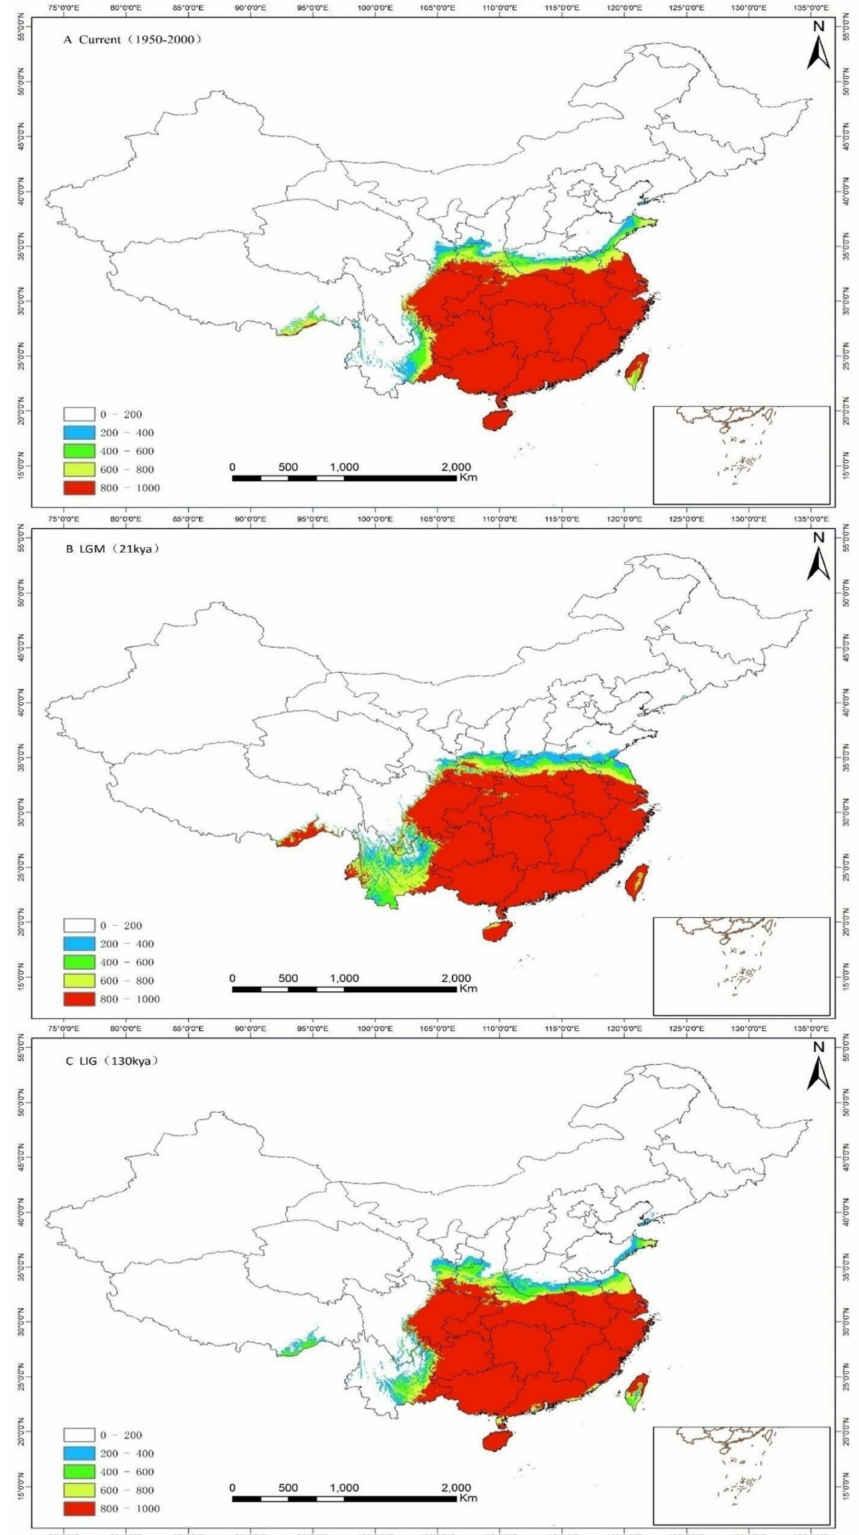
Figure 5. Maps of potential distributions as a probability of occurrence for L. formosana in China at di ff erent times through Biomod2 species distribution model using eight bioclimatic variables. ( A ), at present (1950–2000); ( B ), LGM (21 kya); ( C ), LIG (130 kya). Predicted distribution probabilities are shown in the legend, the deeper color representing the greater the probability